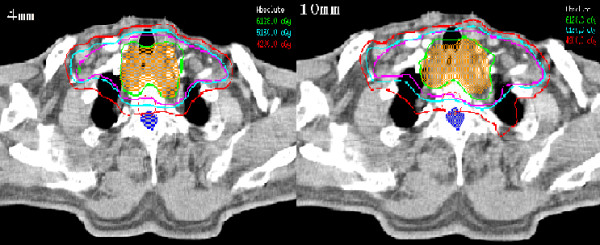
The transverse sections of the representative IMRT plans of one patient with the irradiation isodose curves (10 and 4 mm: MLC leaf widths of 10 and 4 mm, respectively).